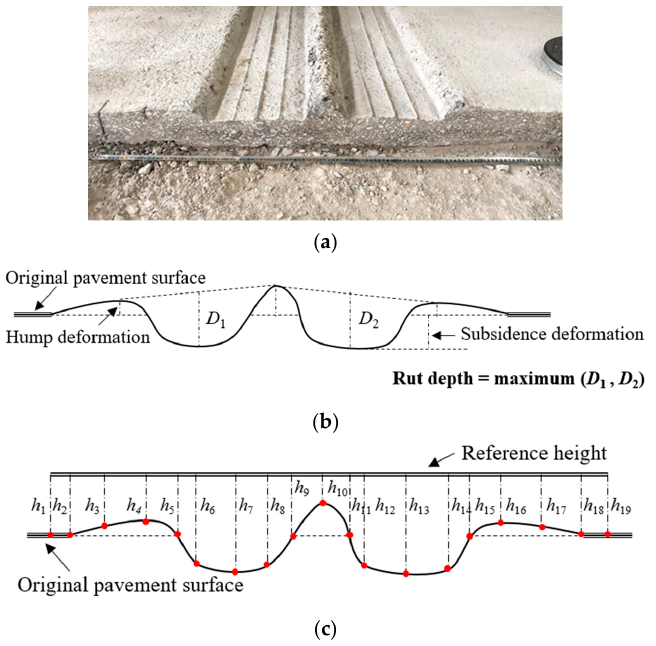
Figure 6. The APT rut deformation result, rut depth definition, and rutting profile measurement method: ( a ) AC layer trench excavation result after APT; ( b ) Rut depth definition; ( c ) Rutting profile measurement method.